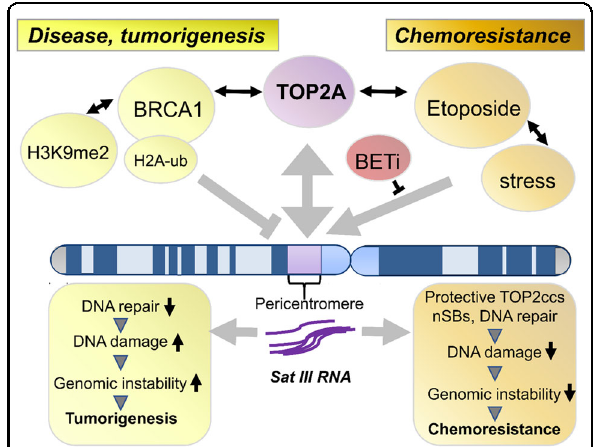
Fig. 5 Model of SatIII regulation in tumorigenesis and chemoresistance. Loss of BRCA1 results in an increased SatIII RNA expression through reduced ubiquitination of H2A and a relaxation of pericentromeric heterochromatin, re fl ected by a loss of H3K9me2 (left side, Zhu et al., 2018, Padeken et al.). SatIII RNA interacts with the BRCA1- associated protein network and destabilizes replication forks which in turn enhances DNA damage and genomic instability, ultimately promoting tumor growth. Etoposide also drives SatIII expression, but in this case, SatIII RNA facilitates the recruitment of TOP2A to TOP2ccs located at nSBs (our data). This leads to less DNA damage and subsequent downstream mechanisms that decrease genomic instability and therefore cells are more resistant against